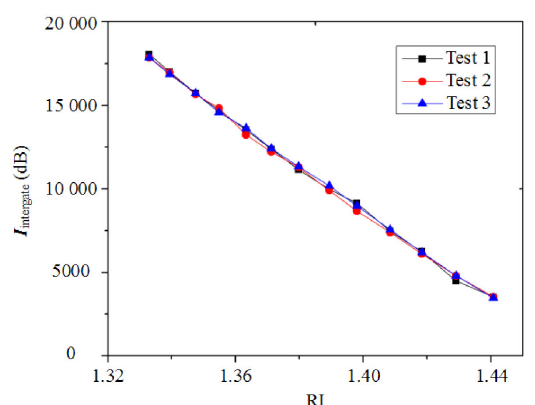
Fig. 8 Relationship between the integrated intensity ( I integrate ) and external RI for three